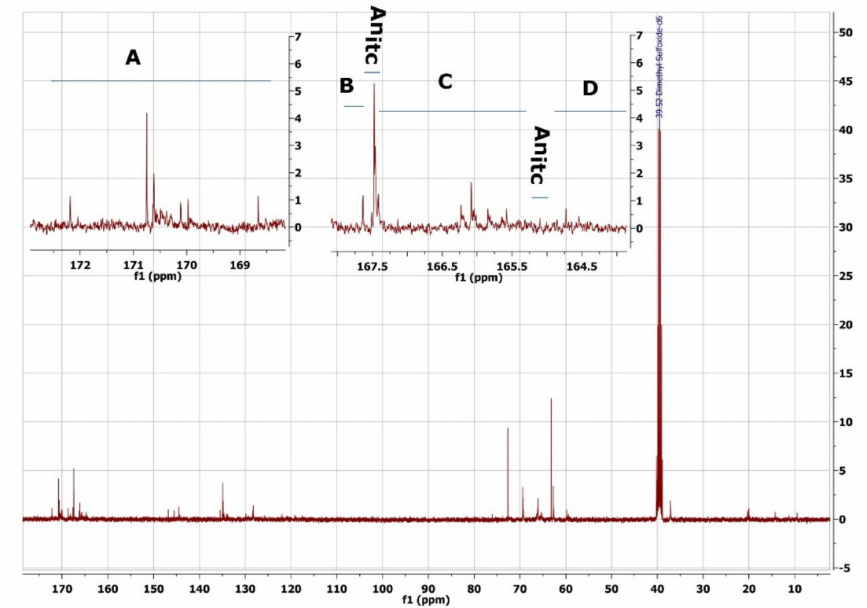
Figure 9. 13 C NMR spectrum of poly(glycerol